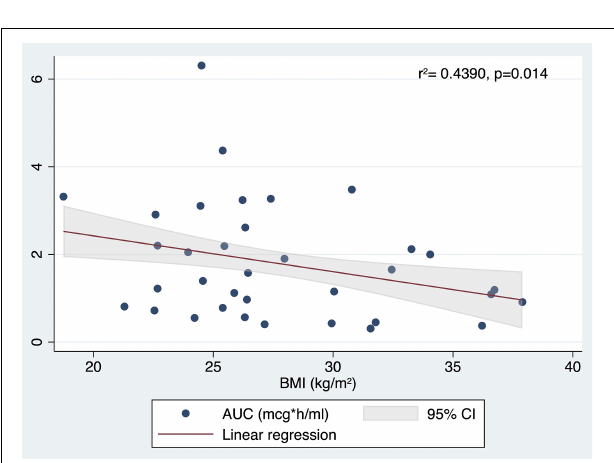
FIGURE 8 | Correlation between AUC (mcg*h/ml) values and BMI (kg/m 2 ).